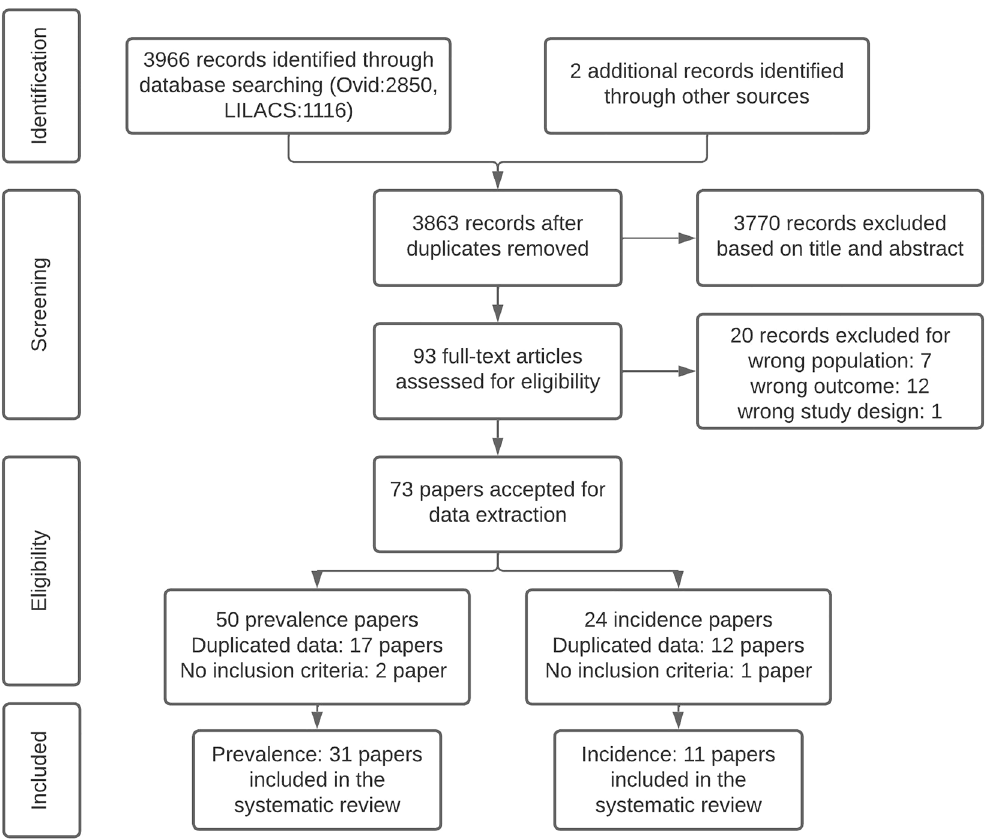
Figure 1. Study selection flowchart. The inclusion and exclusion criteria and the search strategy constructed are shown in detail in the main text and Supplementary Table